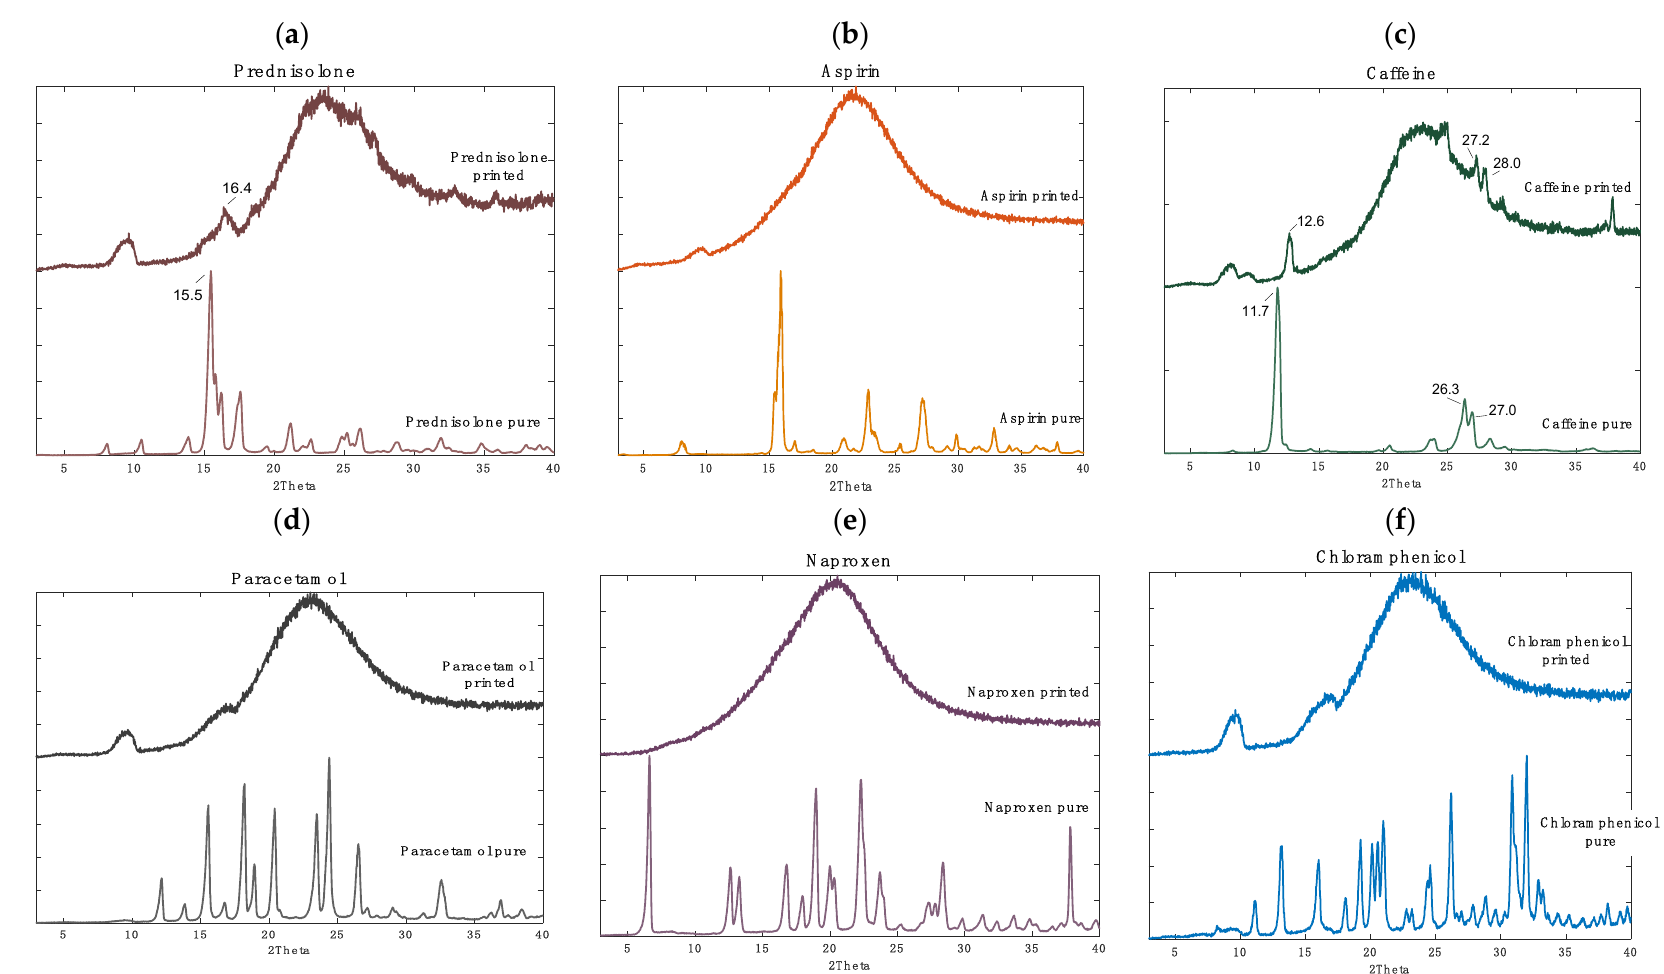
Figure 6. X-ray powder diffractograms of pure and printed drugs: ( a ) prednisolone, ( b ) aspirin, ( c ) caffeine, ( d ) paracetamol, ( e ) naproxen and ( f ) chloramphenicol.